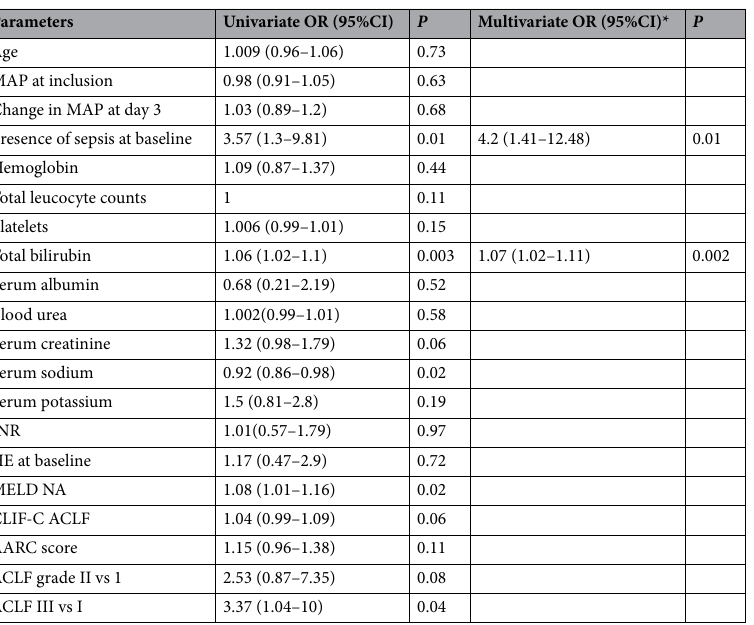
Table 3. Predictors of terlipressin adverse events on univariate and multivariate stepwise logistic regression analysis. MAP mean arterial pressure, INR international normalized ratio, HE hepatic encephalopathy, MELD NA model for end-stage liver disease sodium, CLIF-C ACLF Chronic Liver Failure Consortium acute-on- chronic liver failure score, AARC APASL ACLF research consortium, ACLF acute-on-chronic liver failure. *Presence of sepsis at baseline, total bilirubin, baseline serum creatinine, serum sodium, MELD NA score, CLIF-C score, ACLF grade were included for multivariate